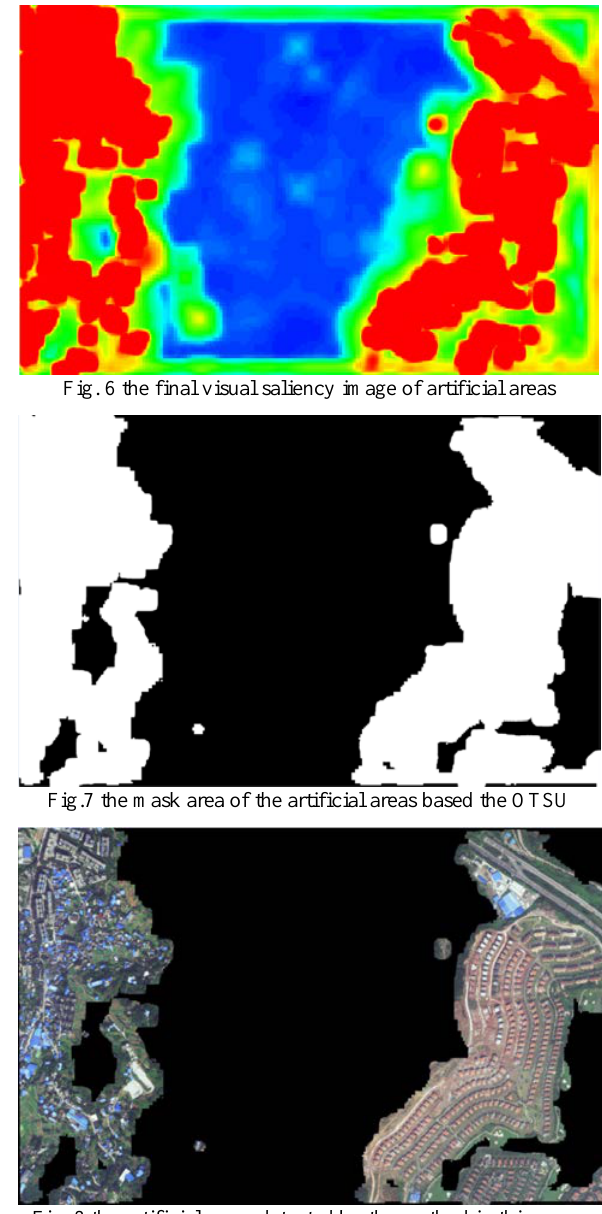
Fig.5 multi scale and multi visual saliency of artificial areas (a) edge features, (b) orthogonal features, (c) local brightness, (d) local contrast, (e) the visual saliency image of scale one, (f) the visual saliency image of scale two, (g)the fusion visual saliency image of all scales